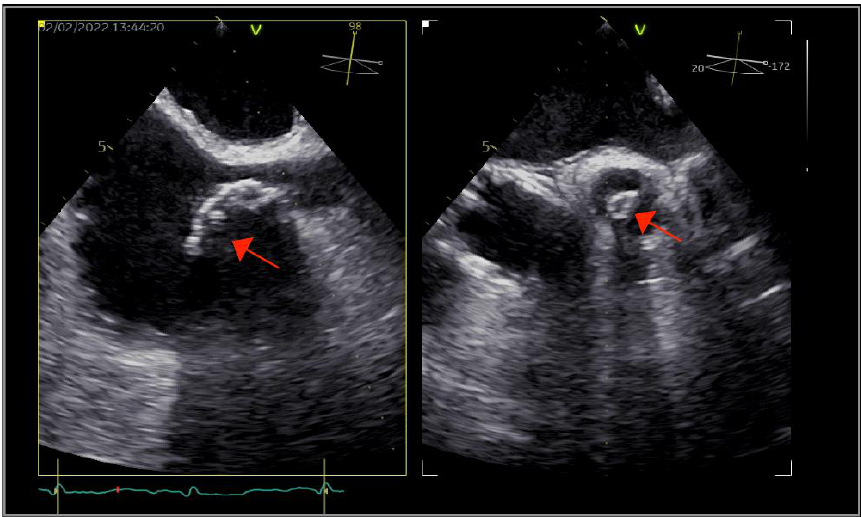
Figure 2. Multi-dimensional transesophageal echocardiography acquisitions showing an inhomogeneous calcified mass at the level of the superior vena cava, with right atrial protrusion (arrow).